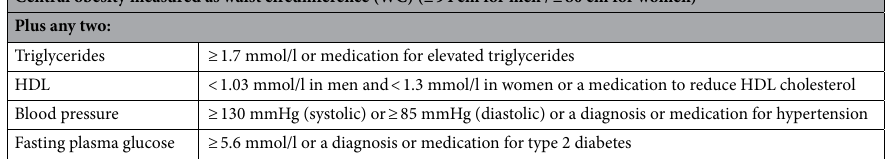
Central obesity measured as waist circumference (WC) (≥ 94 cm for men / ≥ 80 cm for women) Plus any